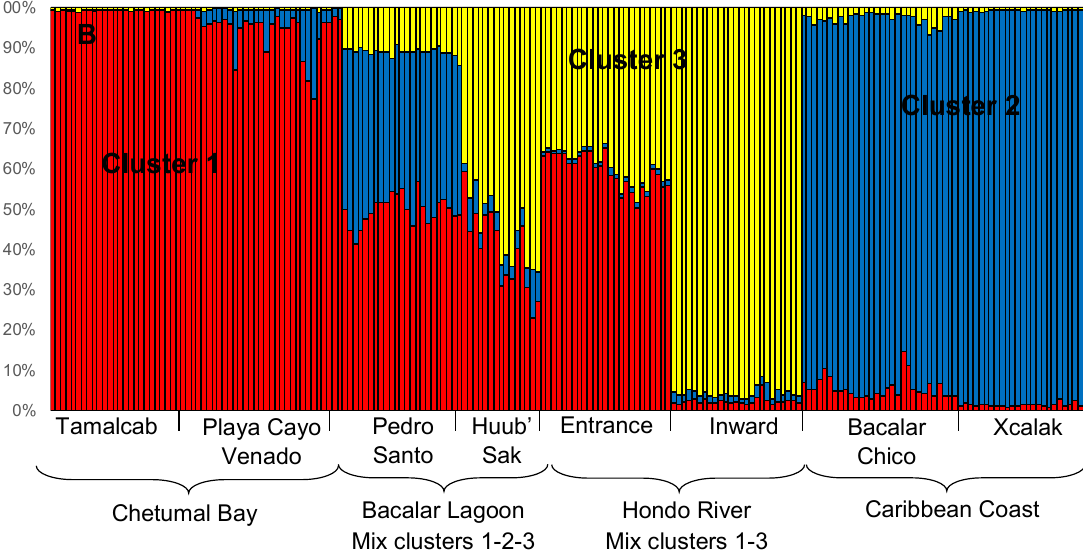
Figure 2. Bayesian analysis of Rhizophora mangle in the Transverse Coastal Corridor, southern Quintana Roo, Mexico, computed by S TRUCTURE 2.3.1 software. ( A ) results for K = 2, ( B ) results for K = 3. Each individual is represented by a single vertical line broken into K segments of length proportional to the estimated membership (probability q i ) in the K clusters.